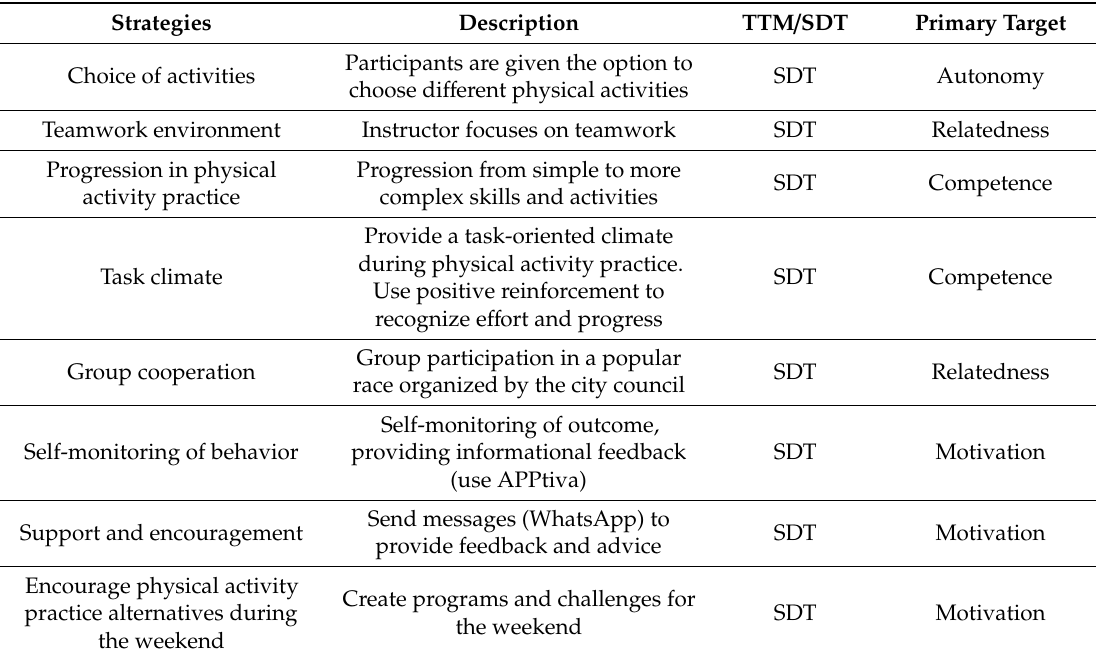
Table 2. Intervention program strategies. Behavioral